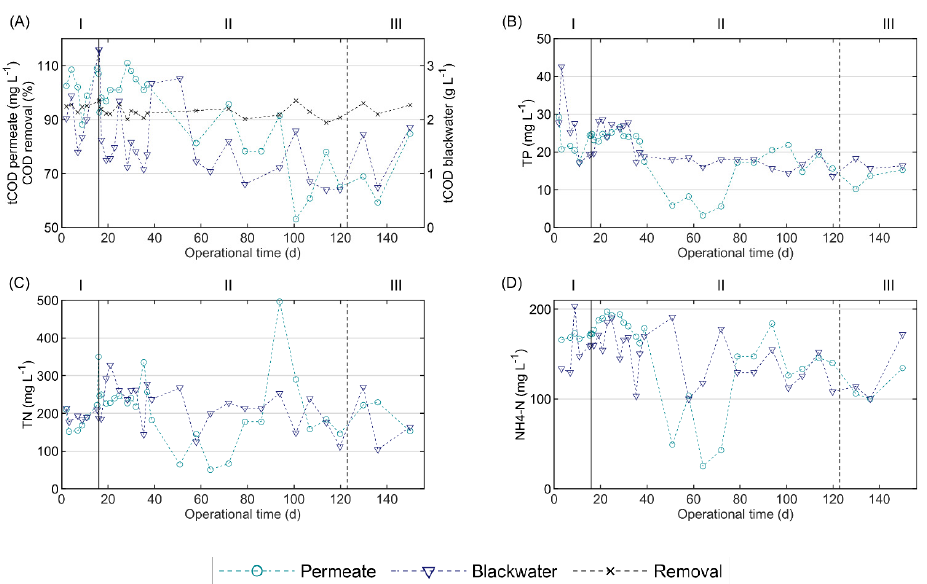
Figure 2. Blackwater and permeate characteristics during the operational period of pilot AnMBR dosed with flux enhancer: ( A ) total COD concentration and COD removal, ( B ) total phosphorous concentration, ( C ) total nitrogen concentration, and ( D ) ammonium-nitrogen concentration. A pulse-dosage of Adifloc KD451 achieving 50 mg L − 1 was performed on day 16 (black continuous line), and sludge was withdrawn on day 123 (black dotted line). I, II and III are the operational phases described as follows: (I) control phase, (II) period following FE addition, and (III) period following sludge withdrawal.